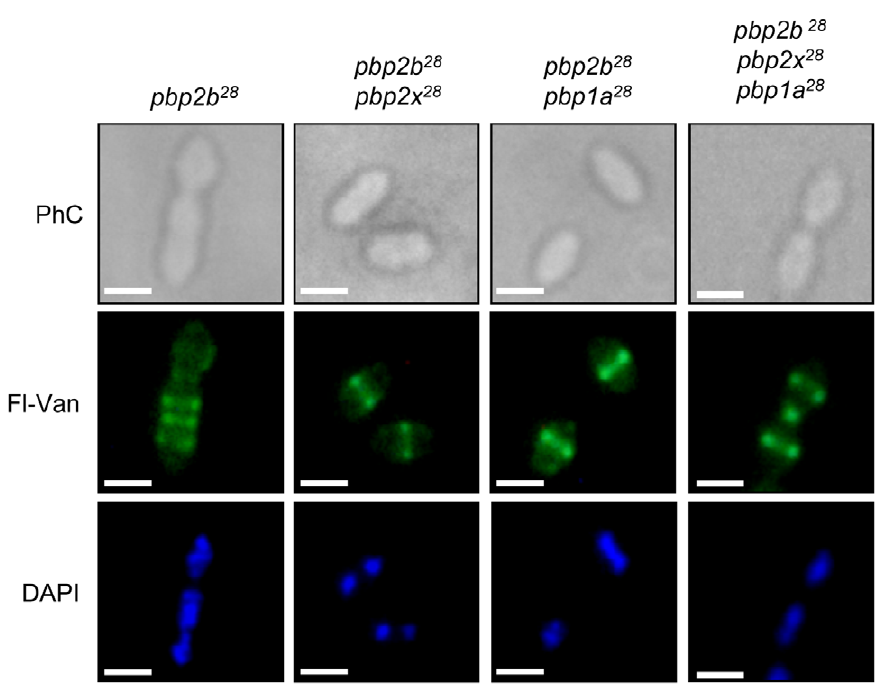
Figure 4. Septal localization in pbp mutants. Exponentially grown cells were stained with DAPI and fluorescent vancomycin (Fl-Van, which labels nascent peptidoglycan synthesis and strongly marks septal localization) and analysed by using an epifluorescence microscope (see Material and Methods). The pbp2b showed a septal accumulation in rod-like shaped cells, whereas the double ( pbp2b pbp2x or pbp2b pbp1a ) and the triple pbp mutants restored their septal localization. Representative images are shown from experiments that were repeated independently three times